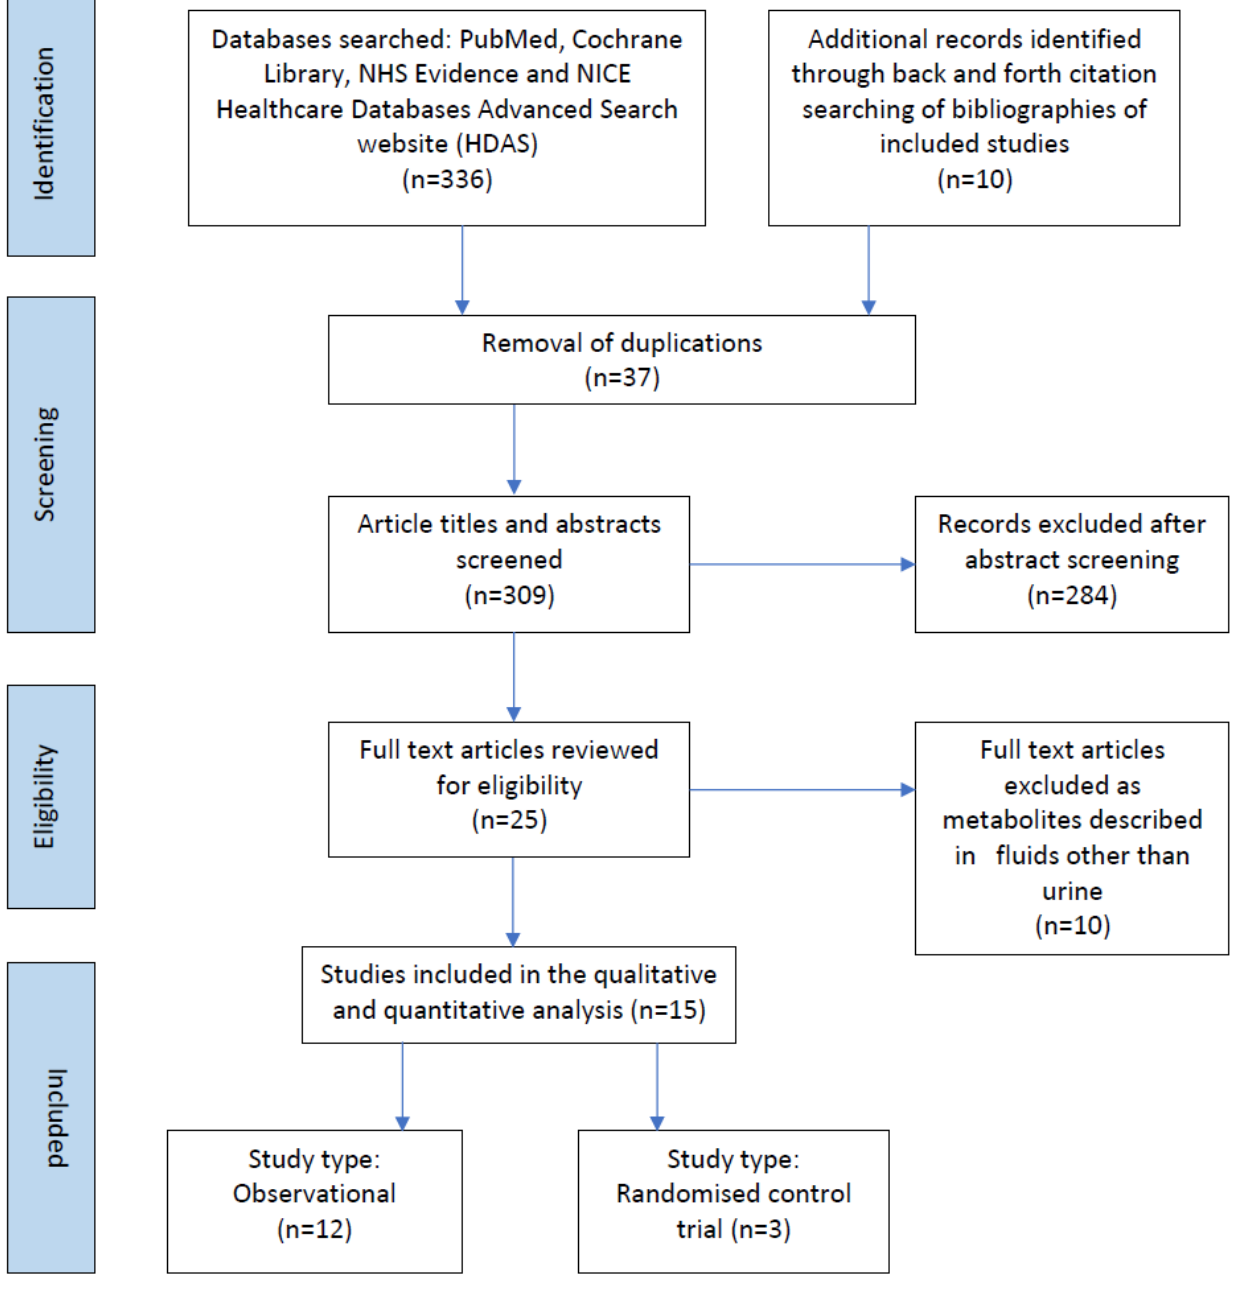
Figure 1. Prisma flow chart of studies included in the scoping review.